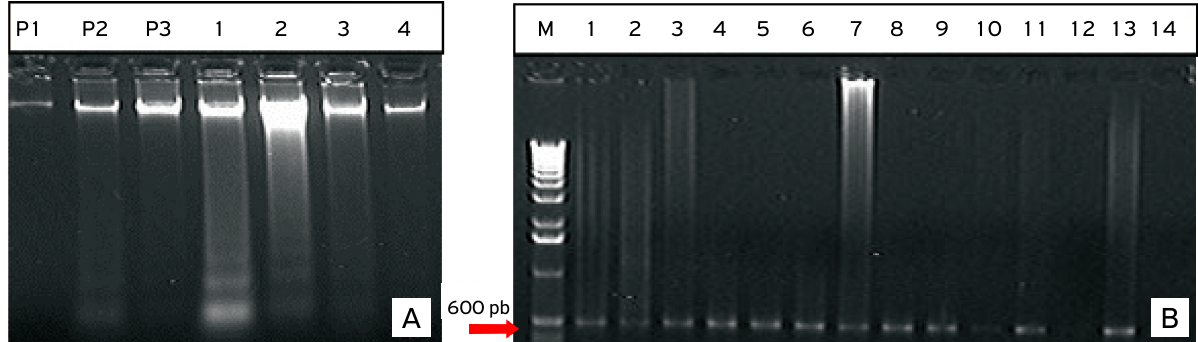
Figure 1. Where A: DNA quantification on 0.8% agarose gel; P1 Lambda marker, 25 ng/mL; P2. Lambda marker 50 ng/mL; P3. Lambda marker 100 ng/mL; Samples 1 and 3 are the product of the extraction of total DNA from 3 heads and sample 4 from 1 head of sharpshooters ( Dilobopterus costalimai ); B: Nested‑PCR using products, obtained from the DNA amplification reaction of the sharpshooter vectors of Xylella . M = molecular weight marker (1‑Kb DNA ladder (Invitrogen®); Samples 1 to 12 = sharpshooter (Dilobopterus costalimai ). Sample 13 is a positive control from a sharpshooter, and sample 14 is a negative control. An amplicon at 600 bp indicates a positive detection of Xylella in that